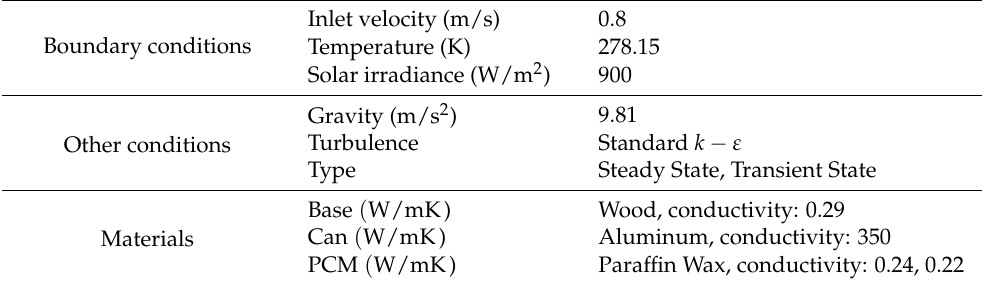
Table 1. Boundary conditions for the computation.